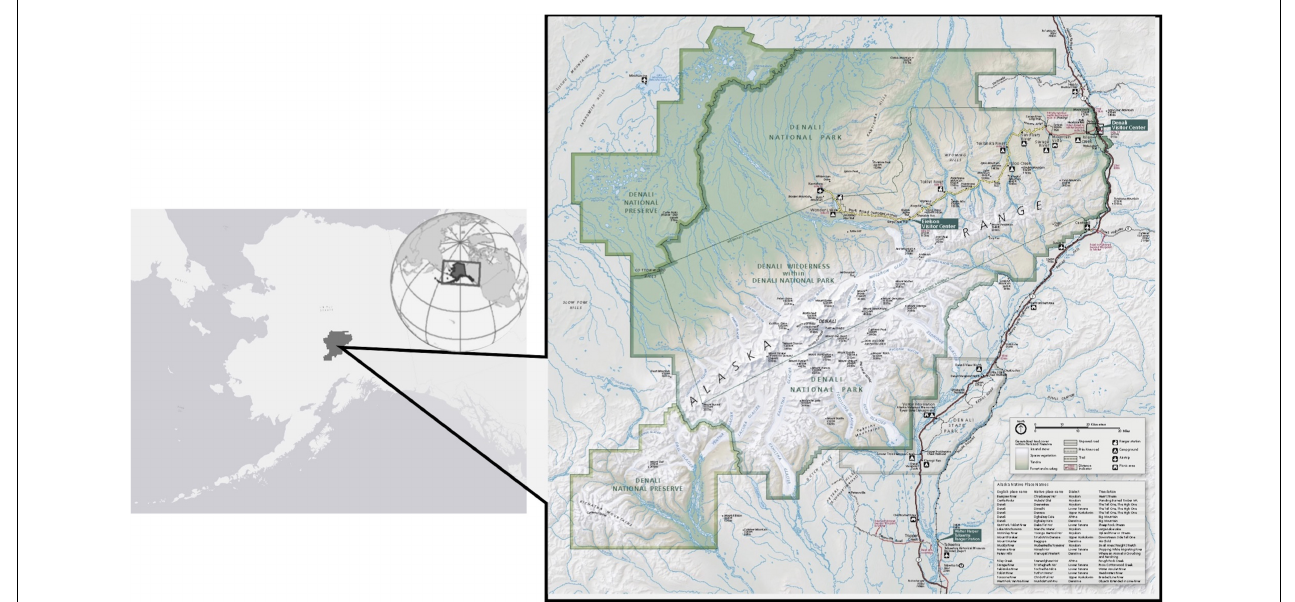
FIGURE 5 | Denali National Park and Preserve (Park Map obtained from https://www.nps.gov/carto/).